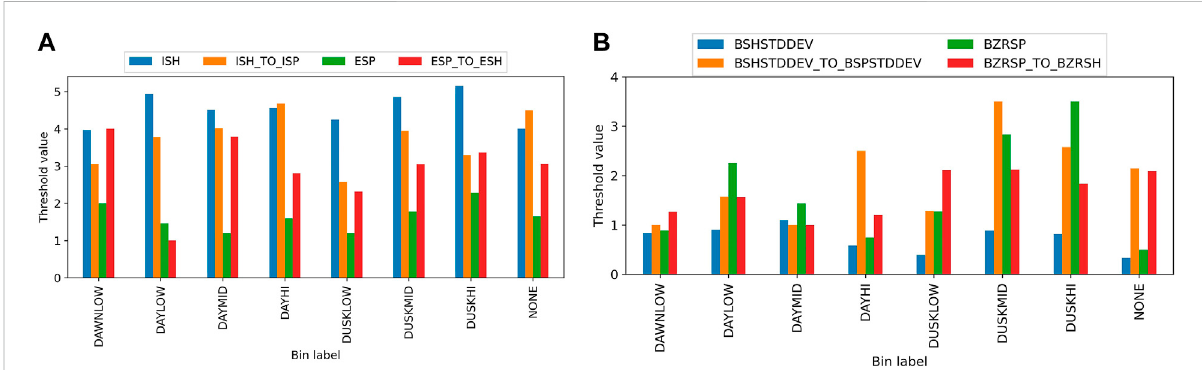
FIGURE 10 The threshold values for MAG data (A) and CAPS data (B) werefound from theBayesian optimisation routinefor each localtime and latitudebin containing mag and caps data. The fi nal bin label ‘ None ’ indicates the thresholds found from the global optimisation with all crossings used.